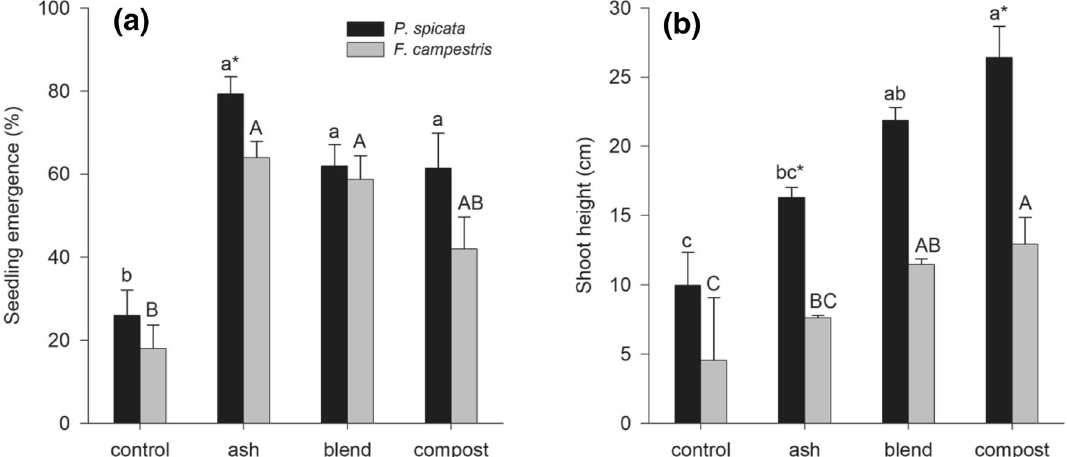
significant within species (lower case = P. spicata ; upper case = F. campestris ) at P < 0.05 (one-way ANOVA, Tukey’s HSD). *Represents a statistical significance between species (determined by Welch’s t -test) for that